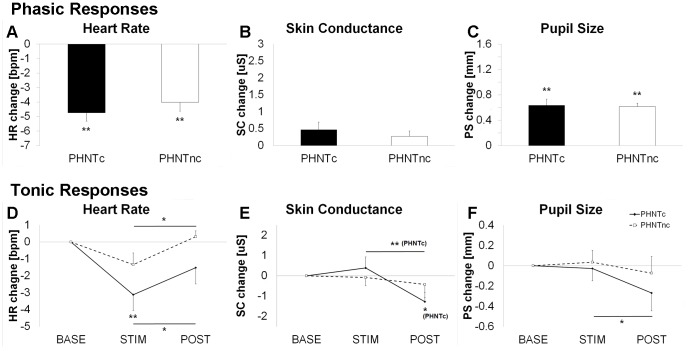
Influence of credibility on autonomic response modulation to phantom acupuncture.Phasic and tonic responses for heart rate (A and D), skin conductance (B and E), and pupil size (C and F) were contrasted between credible (PHNTc) and non-credible (PHNTnc) phantom acupuncture. n.b. *<0.05, **<0.01. Error bars represent standard error of the mean.